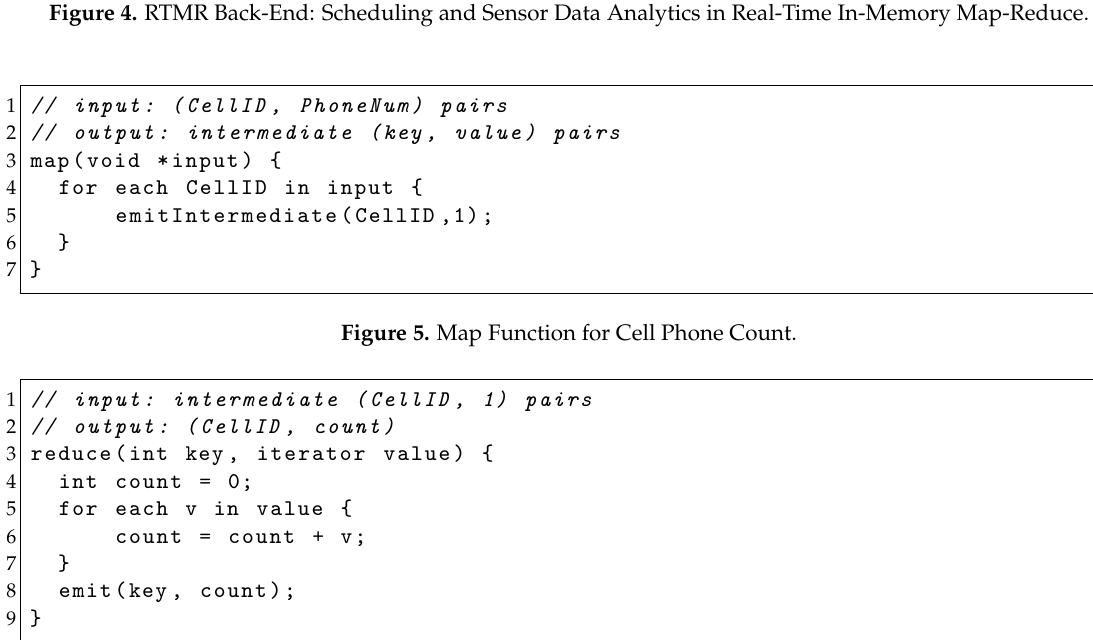
Figure 4. RTMR Back-End: Scheduling and Sensor Data Analytics in Real-Time In-Memory Map-Reduce.